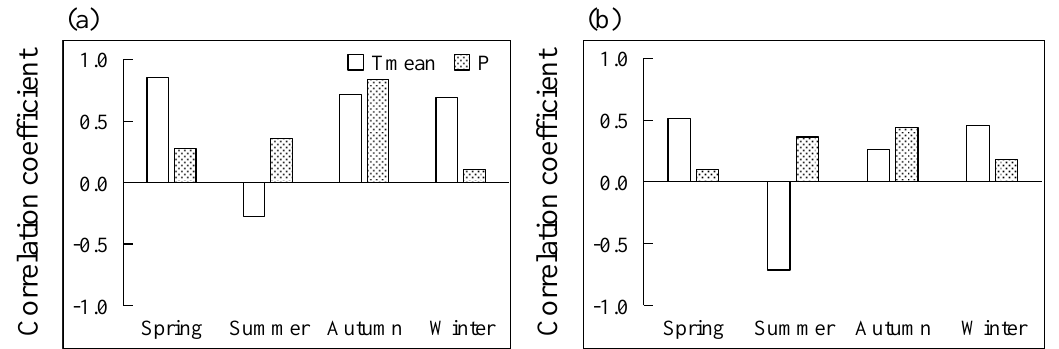
Figure 5. Correlations between radial growth and climate factors in two sites. Tmean is monthly mean temperatures, Tmax is monthly average of maximum temperature, Tmin is monthly average of minimum temperature, and P is precipitation.